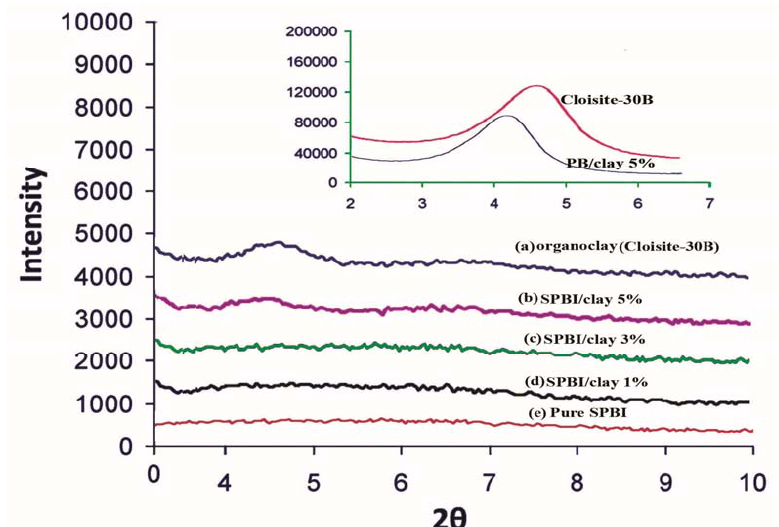
Fig. 4. WAXD plot of organoclay and cross-linked SPBI/clay